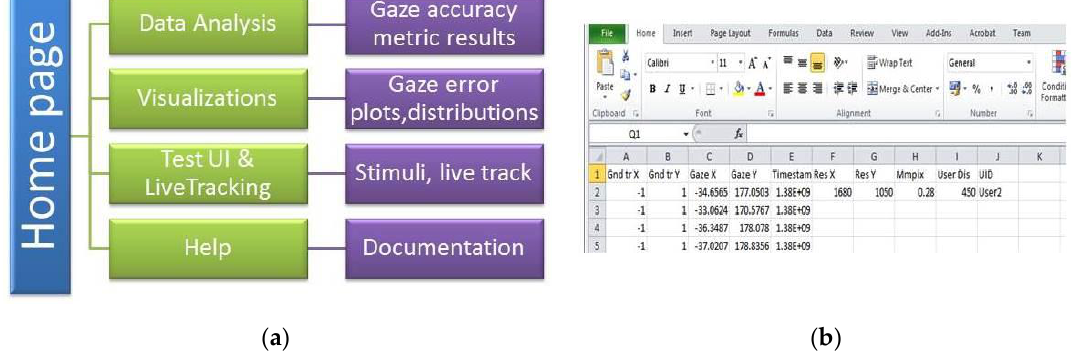
Figure 5. ( a ) Architecture of the GazeVisual software; ( b ) Input data format (CSV) for the software.